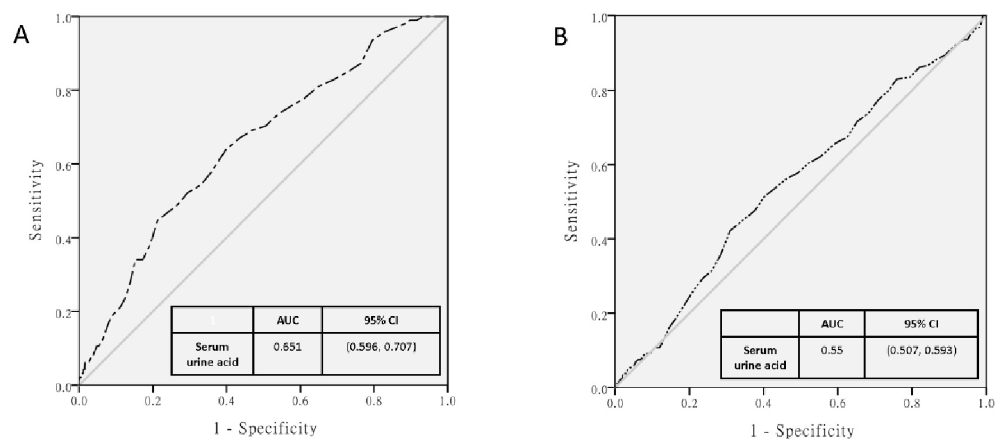
Fig 2. Receiver Operating Characteristic curve (ROC curve) constructed using serum uric acid concentrations (mg/dl) as test variable and diverticulosis as state variable by (A) female and (B) male groups.